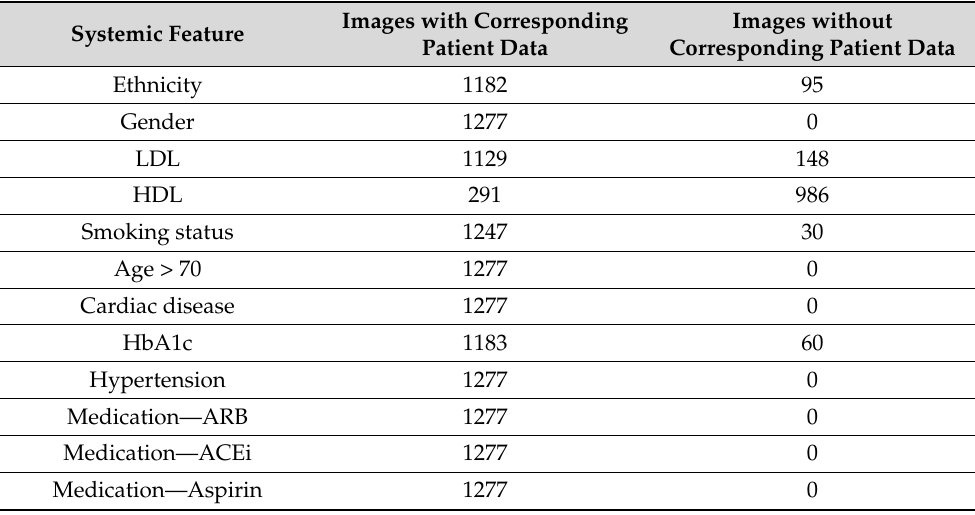
Table 4. Fundus images with corresponding electronic medical record (EMR) feature data. For each of the 12 systemic features of interest, the number of fundus images from among the complete set of 1277 with available corresponding information about the EMR is listed.